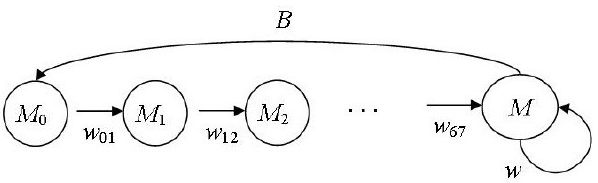
Figure 2. Lifecycle graph of the male part of the northern fur seal population.